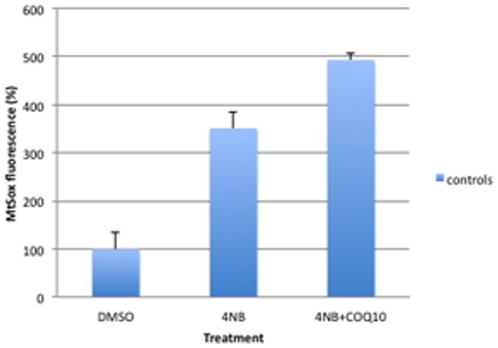
Quantitation of MitoSox staining by flow cytometry in control skin fibroblasts (n = 5) after co-treatment with 4 mM 4-NB+5 µM CoQ10.The values are expressed as percentage of the control skin fibroblasts after 4 mM DMSO (** P<0.01).